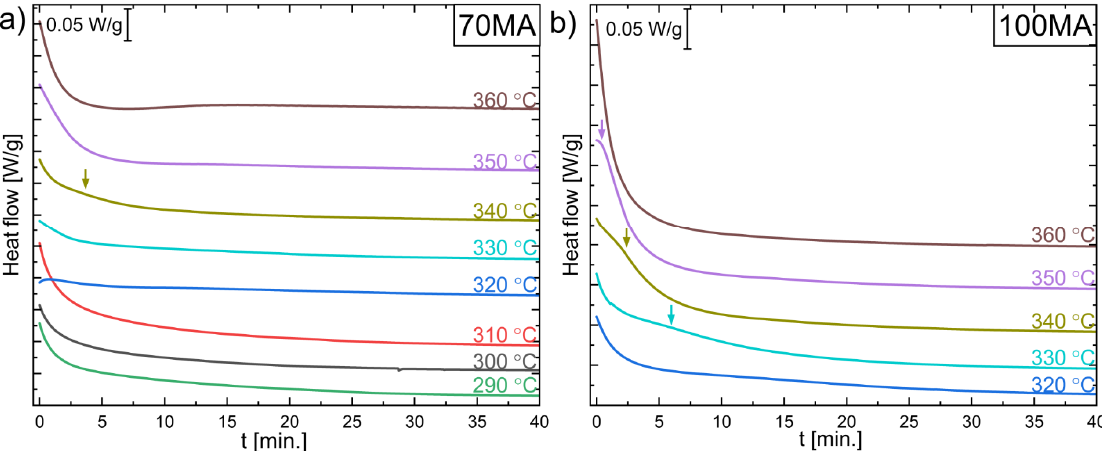
Figure 6. DSC isothermal curves collected at 290 °C, 300 °C, 310 °C, 320 °C, 330 °C, 340 °C, 350 °C, and 360 °C for powder after ( a ) 70 h (70MA) and ( b ) 100 h (100MA) of mechanical alloying. Coloured arrows mark the weak broad peaks.